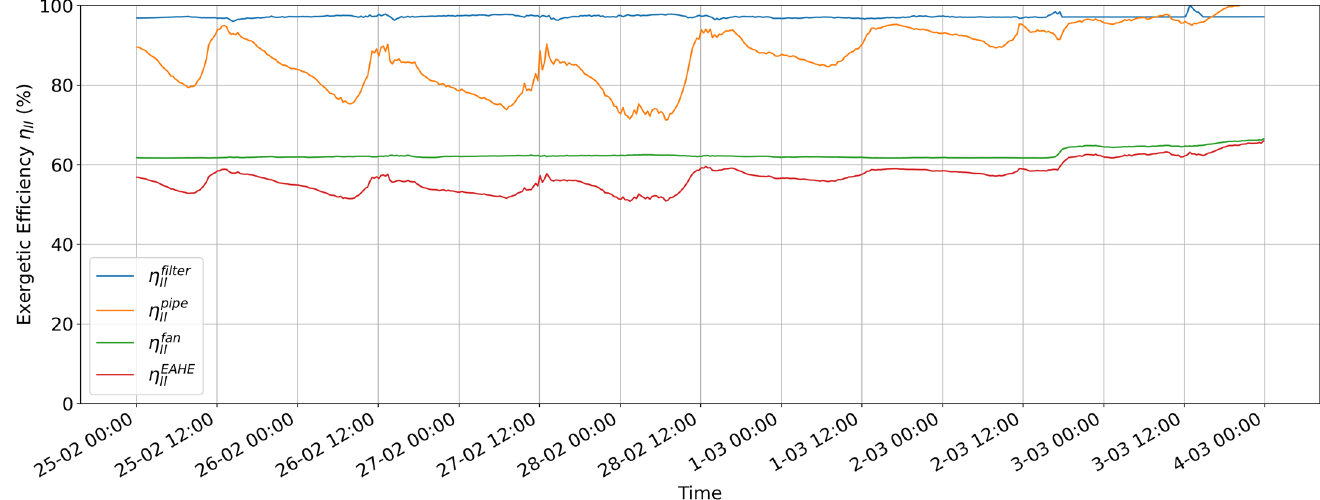
Figure 7. Exergetic efficiency variation in each component of the system during the studied period.